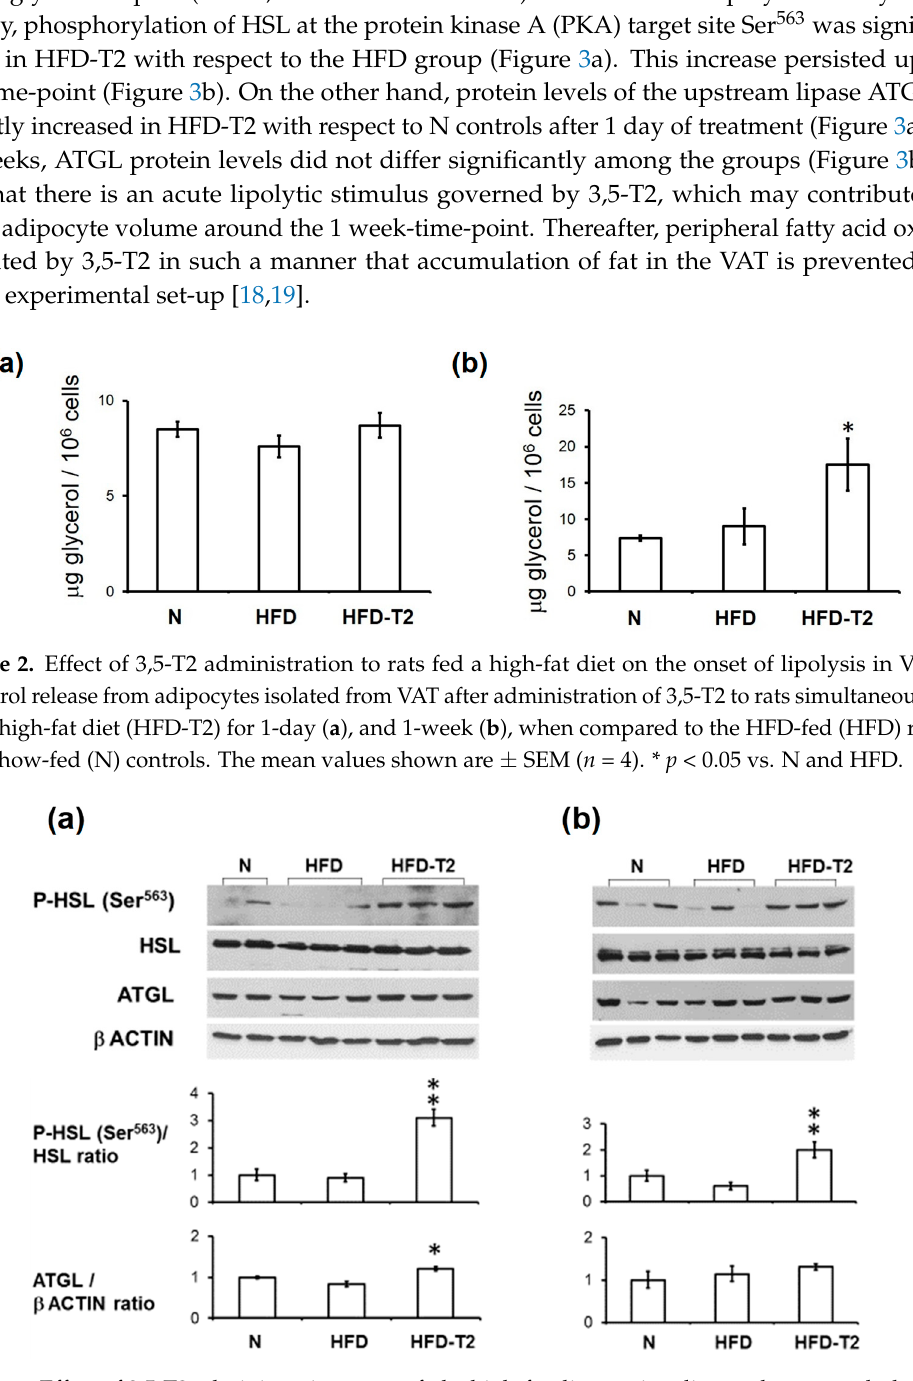
Figure 3. Effect of 3,5-T2 administration to rats fed a high-fat diet on signaling pathways underlying VAT lipolysis. Representative immunoblot analysis for phosphorylation and representation of hormone sensitive lipase (HSL) and adipose triglyceride lipase (ATGL) in VAT upon administration of 3,5-T2 to rats simultaneously fed a high-fat diet (HFD-T2) for 1 day ( a ), and 2 weeks ( b ). Phosphorylation of HSL at Ser 563 was normalized with respect to total HSL. ATGL protein levels were normalized with respect to β -actin. Protein load was 30 µ g/lane. Data were normalized to the value obtained for N animals (set as 1). Shown are the mean values ± SEM ( n = 4). p < 0.05 * vs. HFD; ** vs. N, HFD.